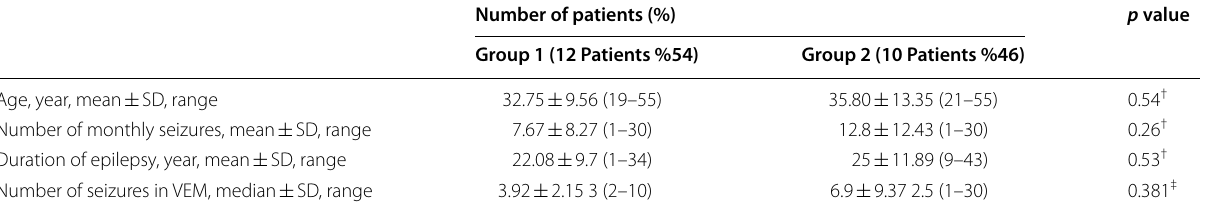
Table 3 Comparison of the age, number of monthly seizures, duration of epilepsy, and the number of seizures in VEM of G1 and G2